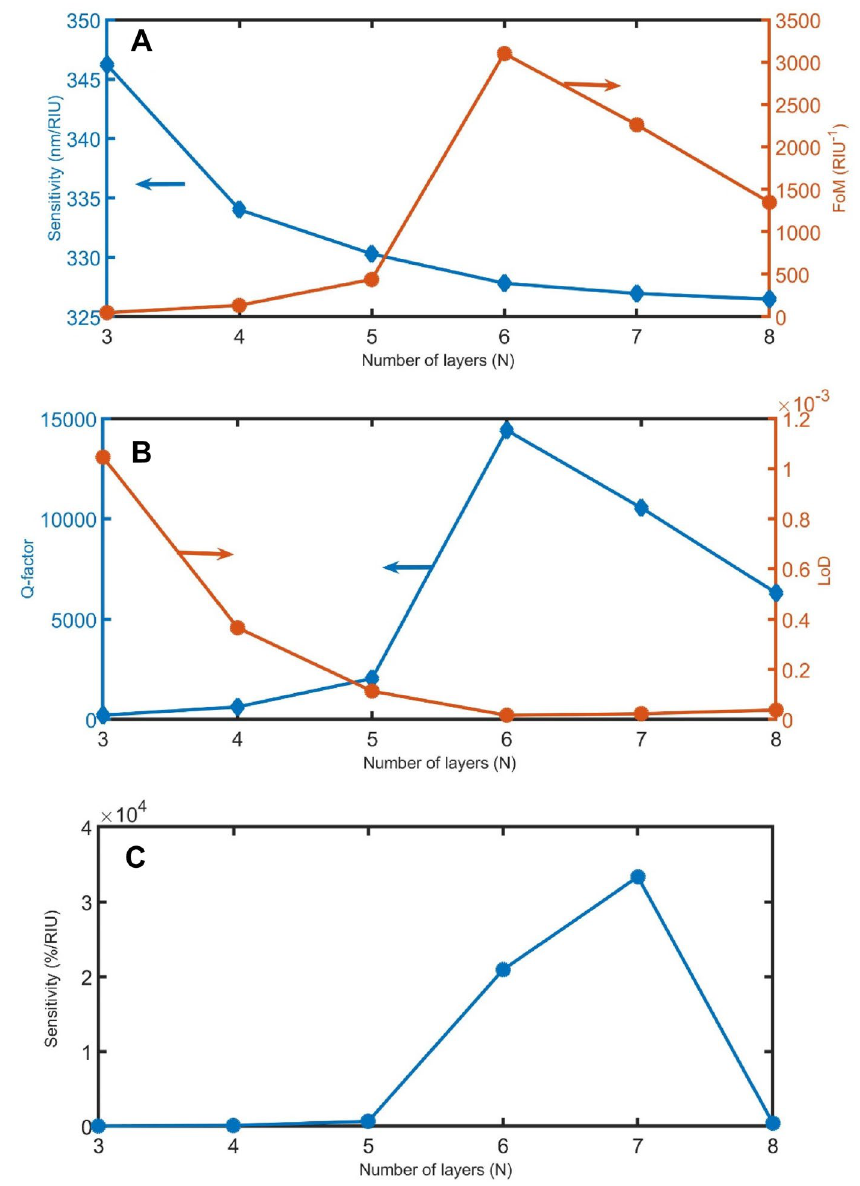
Figure 3. The impact of N on ( A ) sensitivity in nm/RIU and FoM, ( B ) Q and LoD, and ( C ) sensitivity in %/